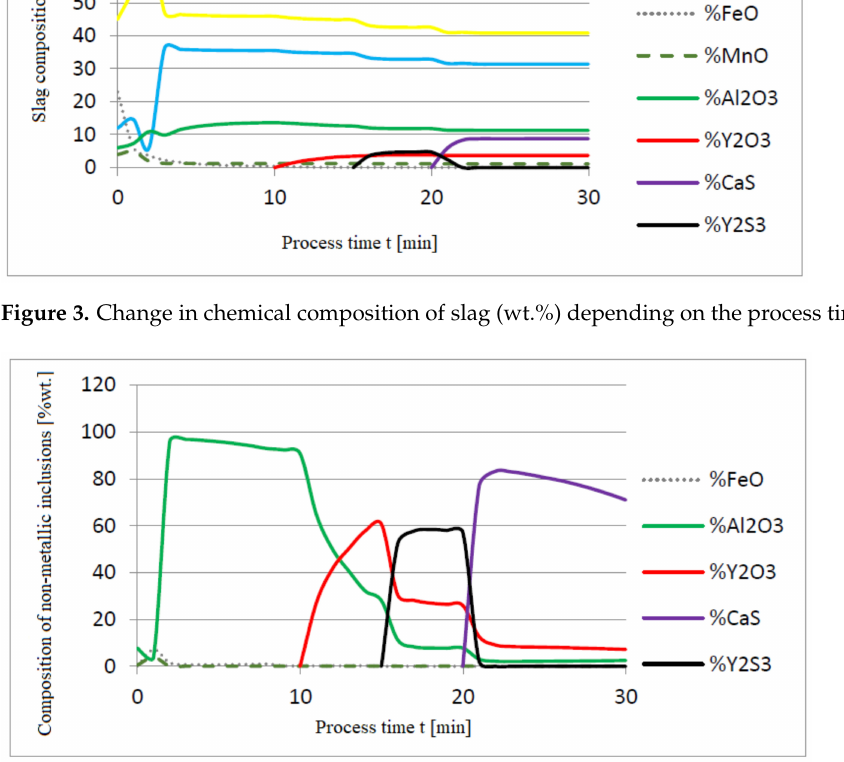
Figure 4. Change in chemical composition of non-metallic inclusions (wt.%) depending on the process